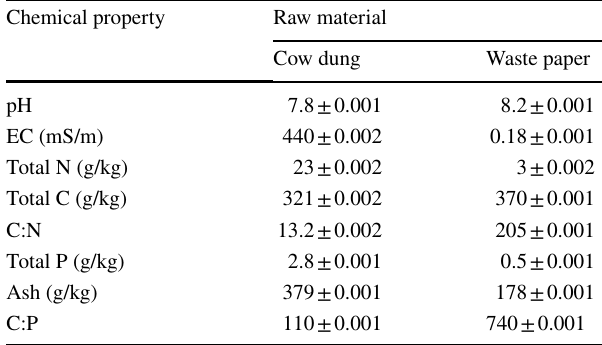
Table 1 Selected chemical properties of wastes used in the study Chemical